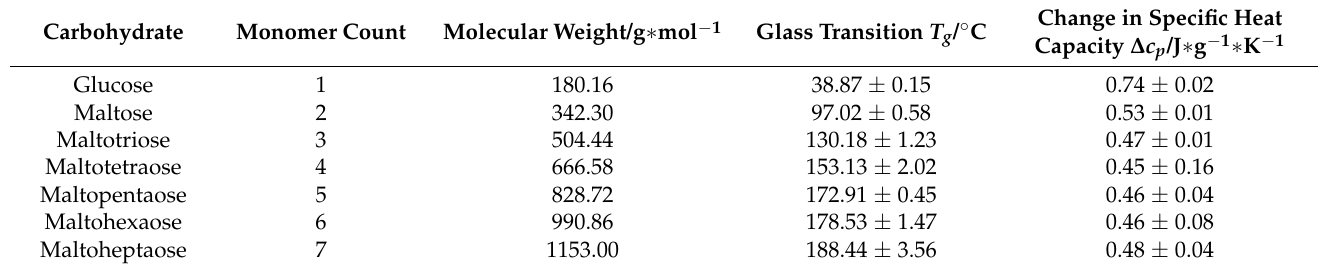
Table 2. Glass transition temperatures ( T g ) and changes in heat capacity at glass transition ( ∆ c p ) for the pure components obtained by differential scanning